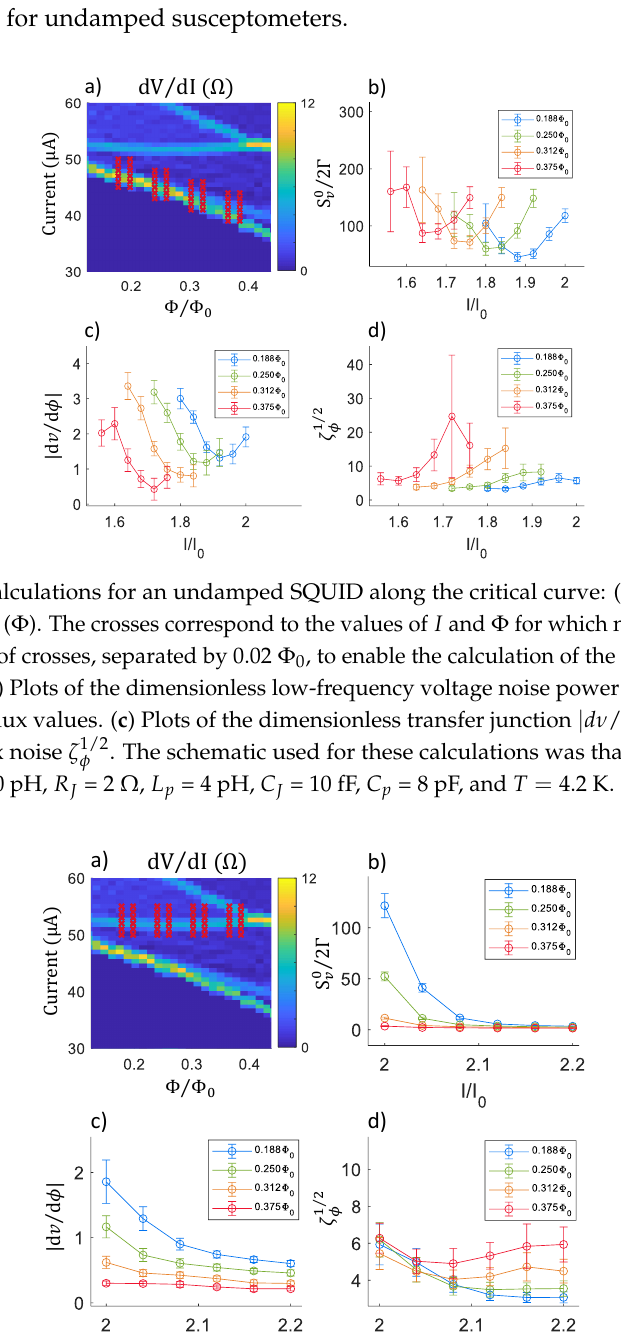
. The schematic used for φ